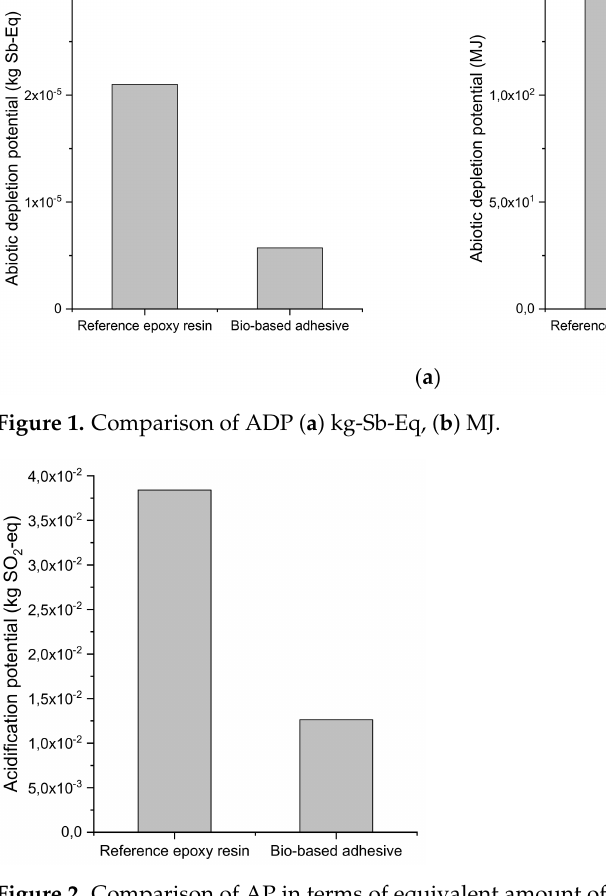
Figure 2. Comparison of AP in terms of equivalent amount of SO 2